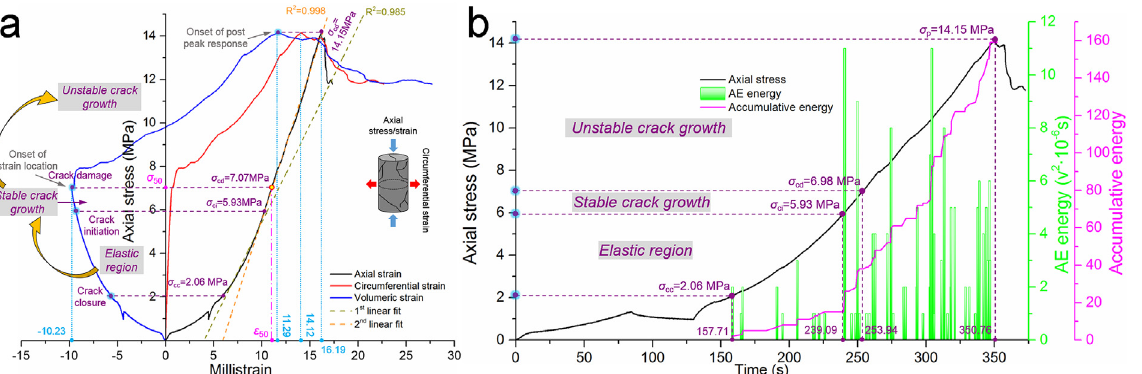
Fig 8. Test results of restored coal No. 2. (a) Relationship between the axial/circumferential/volumetric strain and axial stress under uniaxial compression. (b) Relationship between the time and axial stress/AE energy/accumulative AE energy under uniaxial